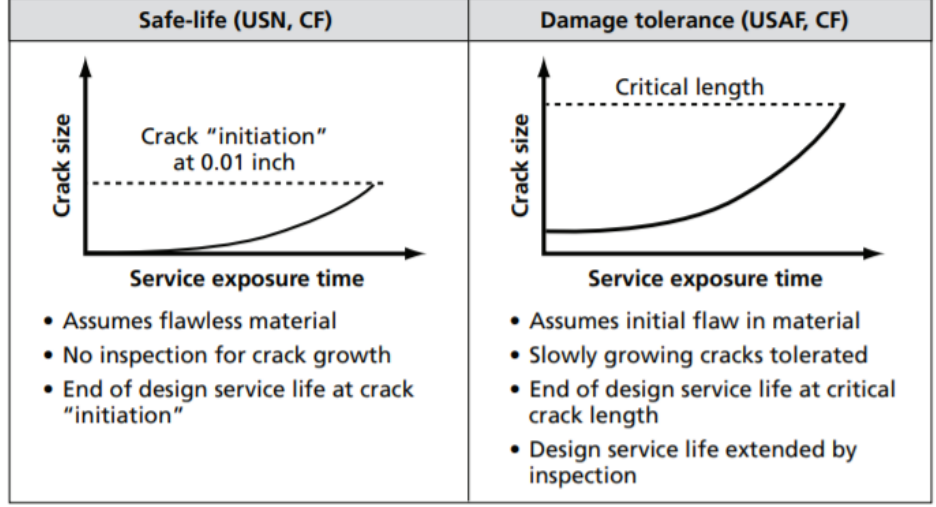
Figure 1. Safe life and damage tolerance concept [10].